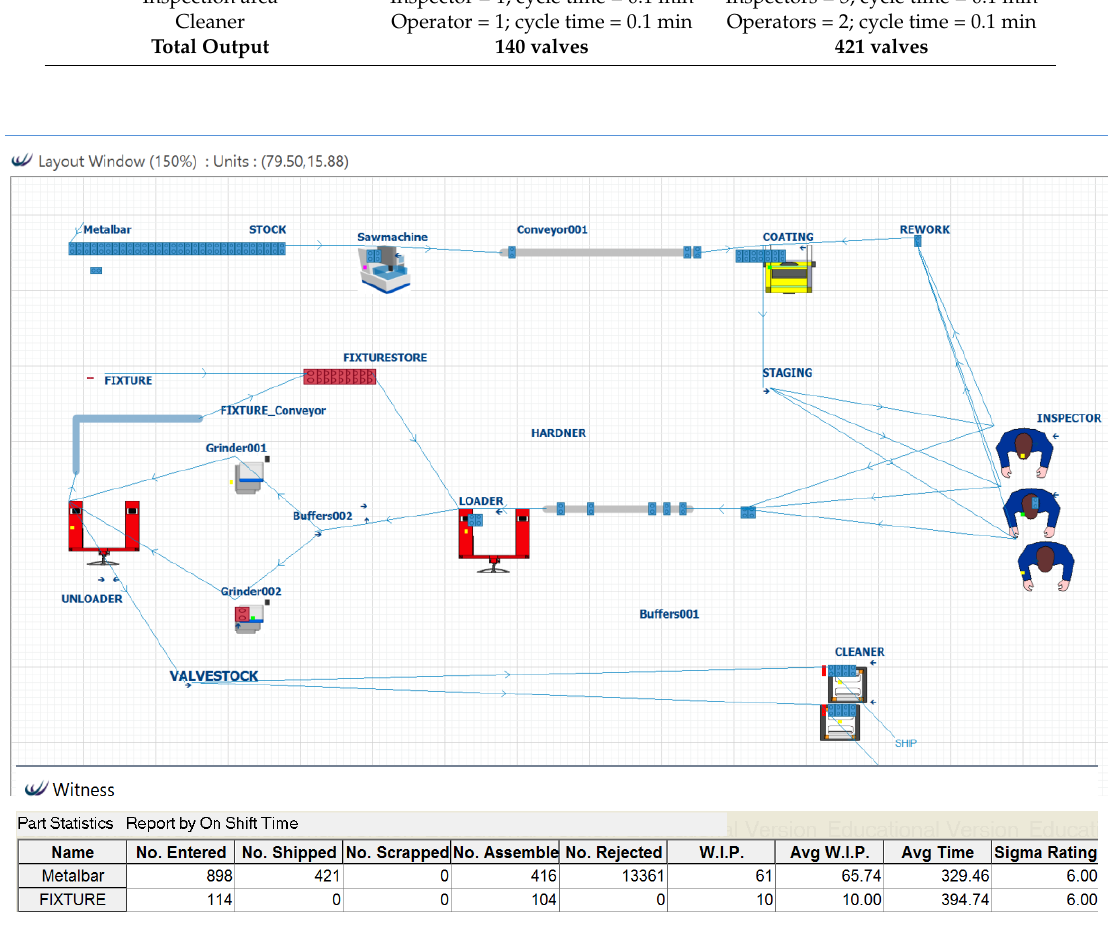
Figure15. Buffer statistics for shift time.